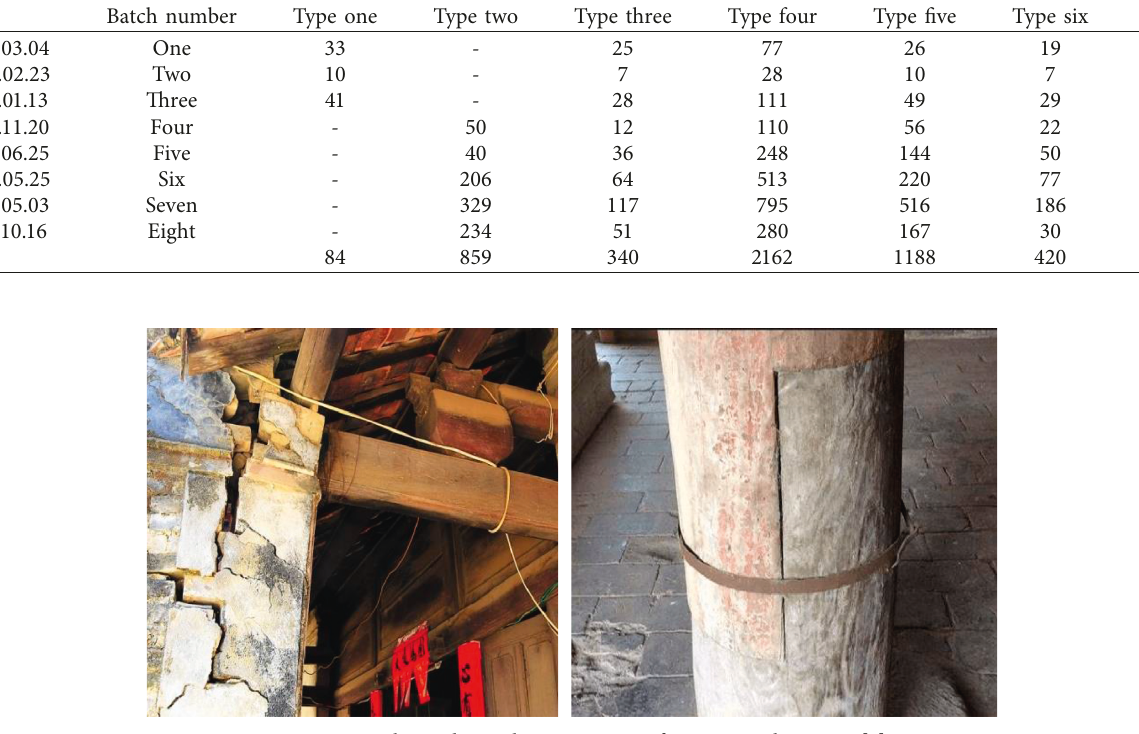
Figure 1: Cracks in the timber structures of ancient architecture